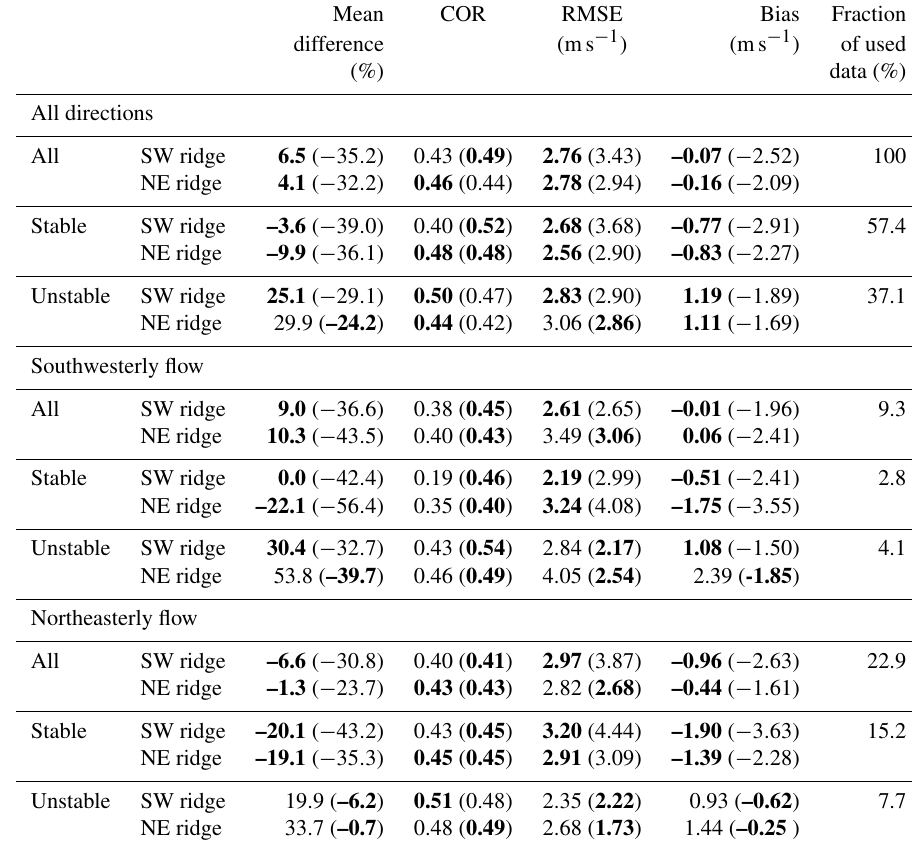
Table 4. Mean difference of WRF simulations and ridge scans calculated as ( U WRF − U lidar ) U Correlation coefficient (COR) and root mean square error (RMSE) values for the comparison of WRF data with the ridge scan measurements. The first number states the value for the WRF_NF simulation without forest parameterization and the number in brackets the value for the WRF_F run with forest parameterization. Bold values indicate the best model per parameter. The percentage of lidar observations, which describe the respective flow condition, is indicated in the last column.